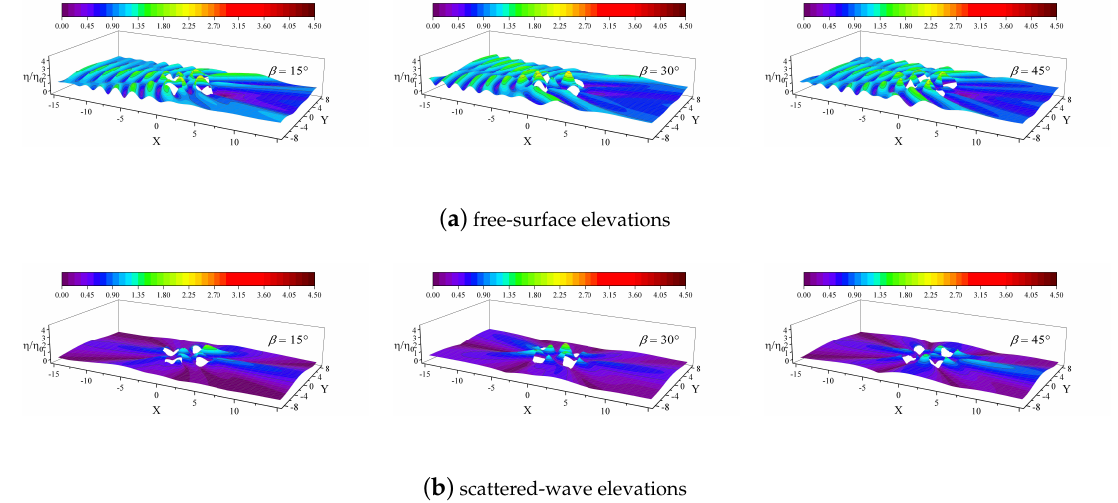
Figure 9. The free-surface and scattered-wave elevations of the four-column structure at k 0 a = 1.68 against three different wave-approach